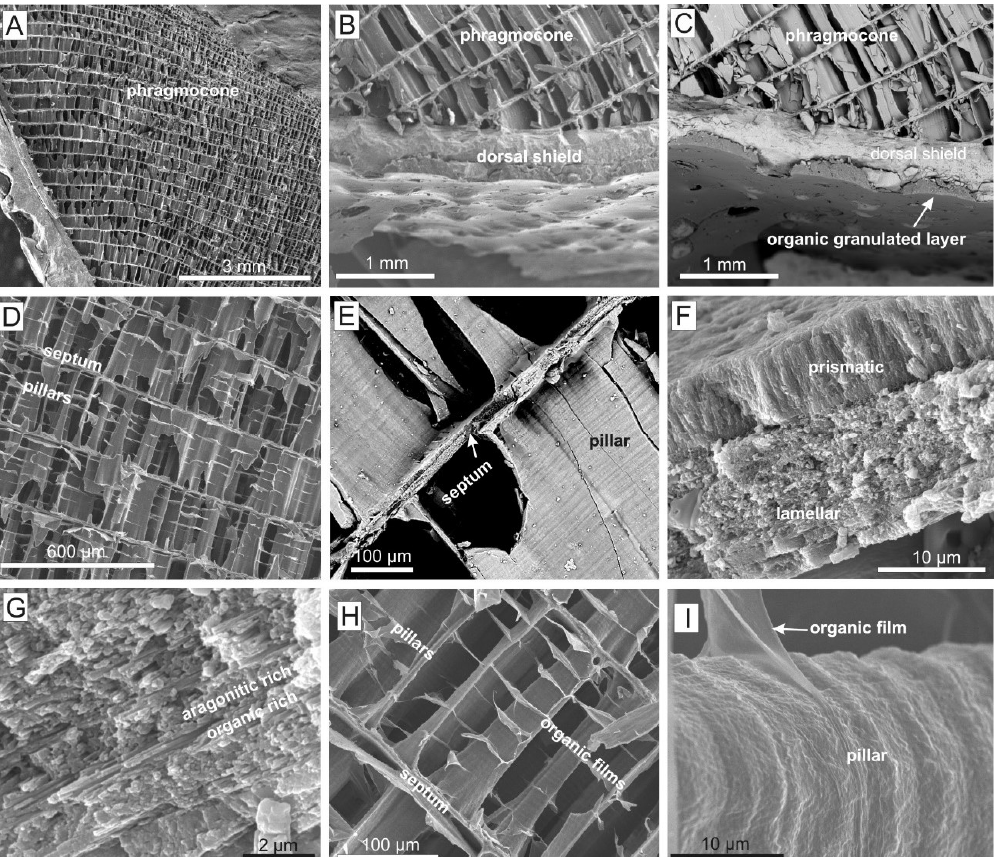
Figure 11. Phragmocone structure of Sepia. ( A ) Distal end of cuttlebone with contact between dorsal shield and youngest chambers of the phragmocone (SP-10). ( B ) General view of the phragmocone and the dorsal shield of Sepia officinalis under the SEM (SP-07). ( C ) General view of the phragmocone and the dorsal shield of S. officinalis under BSEM (SP-02); note that the organic granulated layer is darker than the rest of the dorsal shield. ( D ) Detail of the phragmocone of S. officinalis (SP-03) composed by septae supported by undulating transverse pillars or palisades. ( E ) BSEM image (SP-02) of undular plates with alternating dark (organic rich) and white (aragonite rich) layers. ( F ) Detailed view of a septum (SP-07) composed of two layers, the anterior (~9 µm) is of prismatic structure with fine and densely arranged prisms perpendicular to the septum, and the posterior layer is lamellar (~15 µm). ( G ) Lamellar layer is composed of an alternation of organic and aragonitic-rich sublayers (SP-07). ( H , I ) Detail of the pillars between septae showing the rhythmic growth as well as the presence of organic films (SP-07).